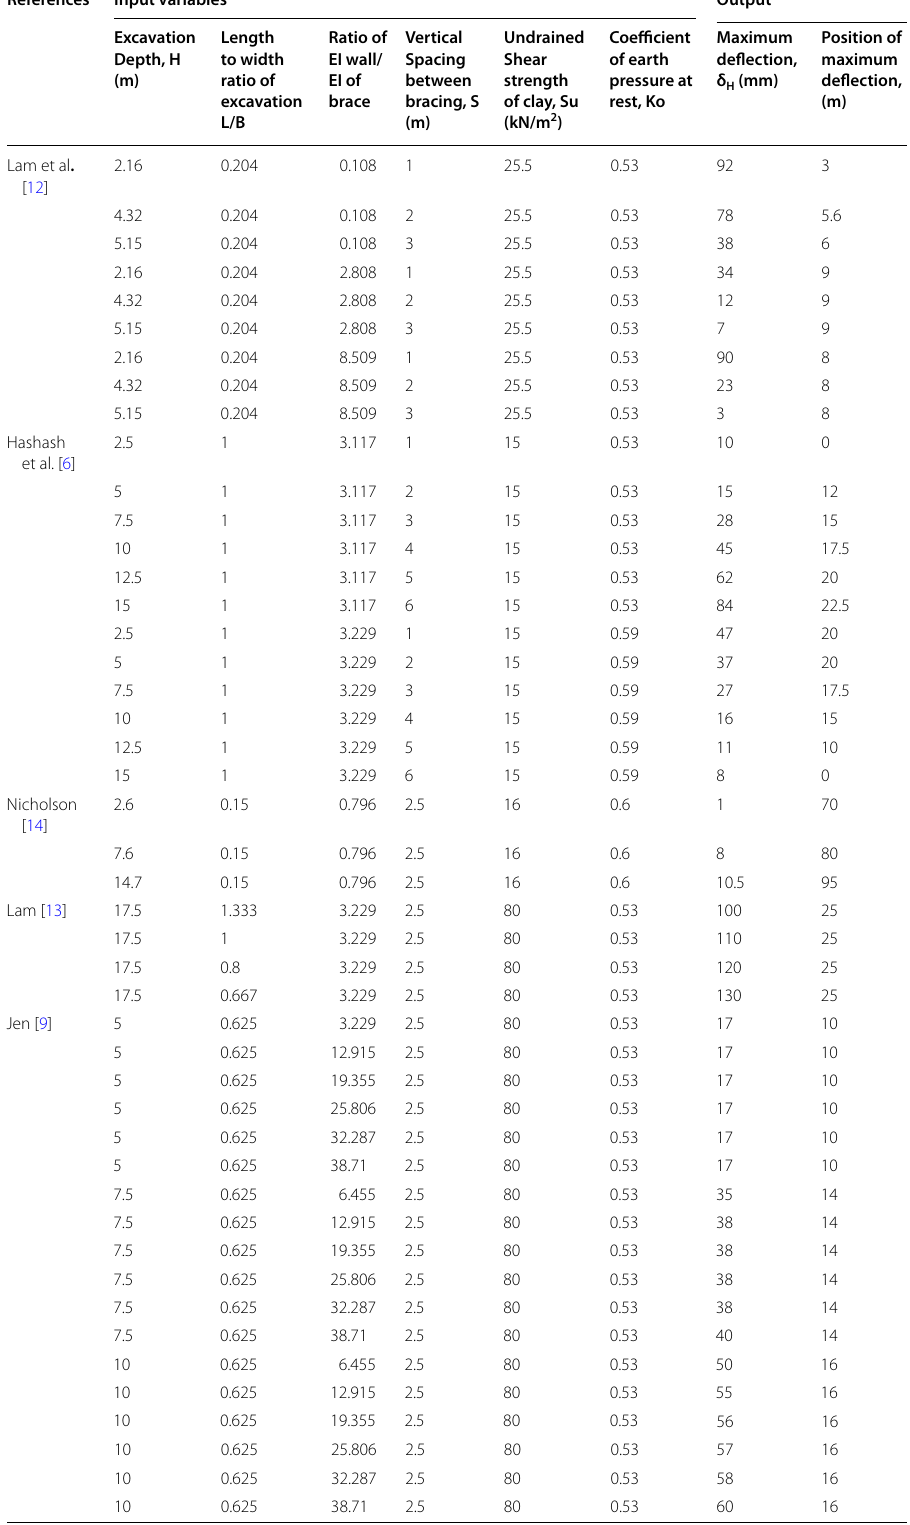
Table 1 Data used in building the neural